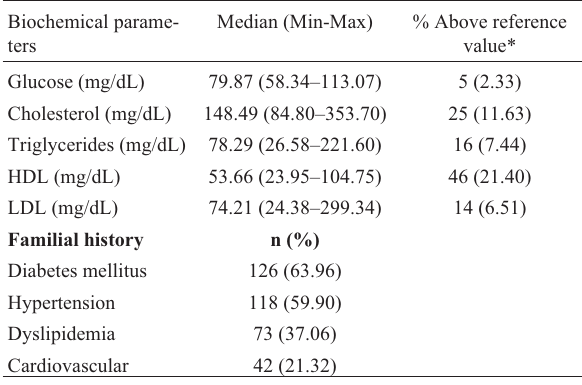
Table 2 - Biochemical parameters and hereditary backgrounds.